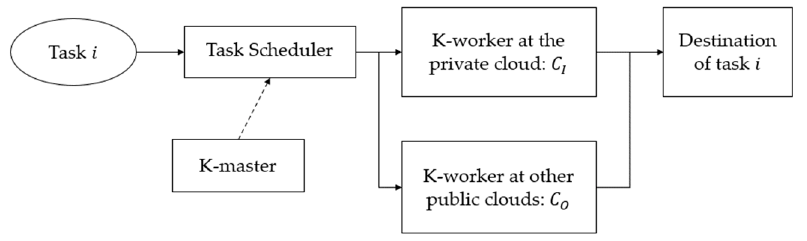
Figure 2. Task scheduling model in cloud orchestration.